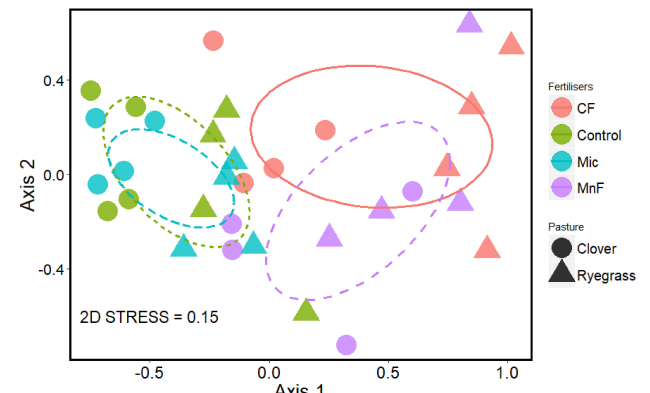
Figure 8. Non-metric multidimensional scaling (NMDS) ordination plot at 97% similarity OTU level, showing differences in mycorrhizal fungal community composition in roots of subterranean clover (circles) and annual ryegrass (triangles) at 10 weeks. The soil treatments were chemical fertilizer (CF), rock mineral fertilizer (MnF), microbial inoculant (Mic) and untreated soil (control). Ellipses represent 95% confidence